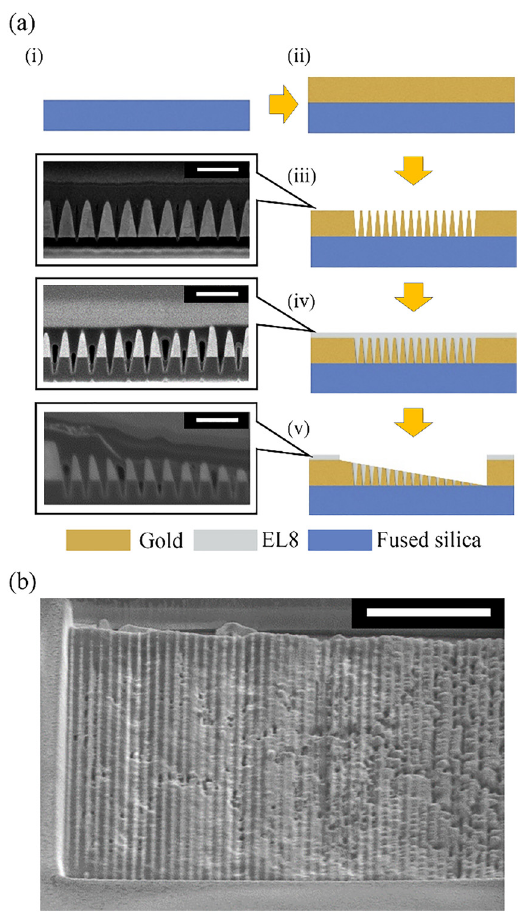
Figure 3: Fabrication of a vHMM. (a) Fabrication process of a vHMM.(i) Preparation of a cleaned fused silica substrate; (ii) deposition of 400 nm-thick gold layer; (iii) fi rst FIB milling to pattern the gold grating structures; (iv) spin-coating EL8; (v) second FIB milling to yield the fi nal prism structure. Scale bar: 500 nm. (b) Scanning electron microscope image of the fabricated vHMM. Scale bar: 3 μ